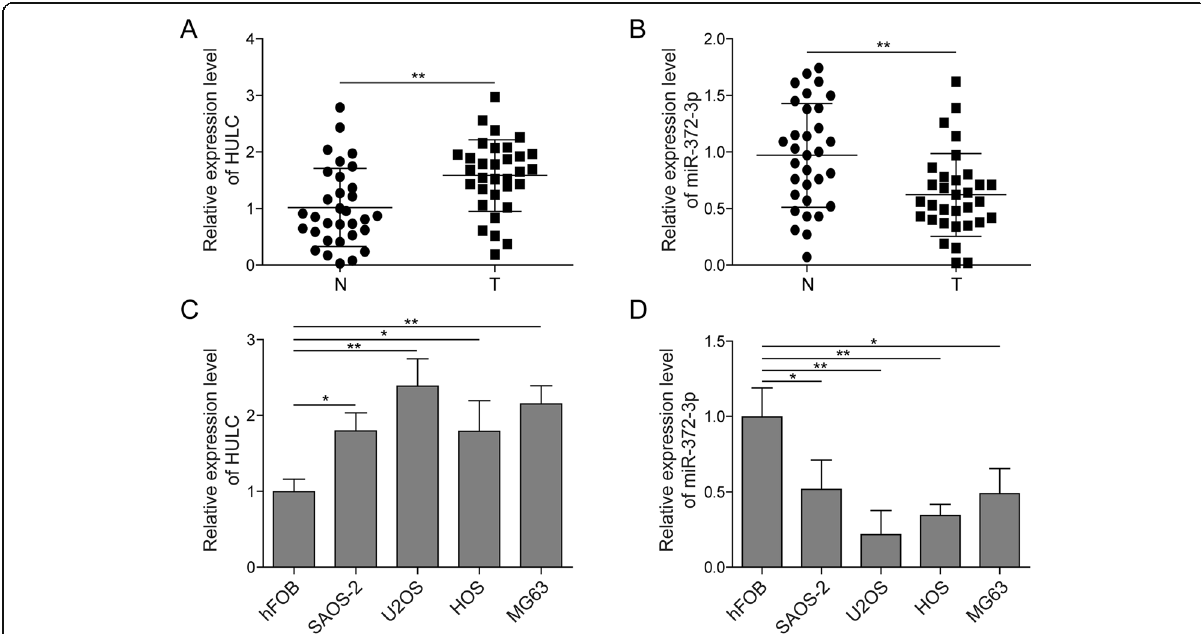
Fig. 1 HULC was upregulated while miR-372-3p was downregulated in osteosarcoma tissues and cell lines. The expression levels of HULC and miR-372-3p were measured in osteosarcoma samples and normal tissues ( n = 32) by qRT-PCR (A&B). The expression levels of HULC and miR-372- 3p were tested in osteosarcoma cell lines (SAOS-2, U2OS, HOS, MG-63) and an osteoblastic cell line (hFOB) by qRT-PCR (C&D). Data are shown as the mean ± SD. * p < 0.05, ** p <